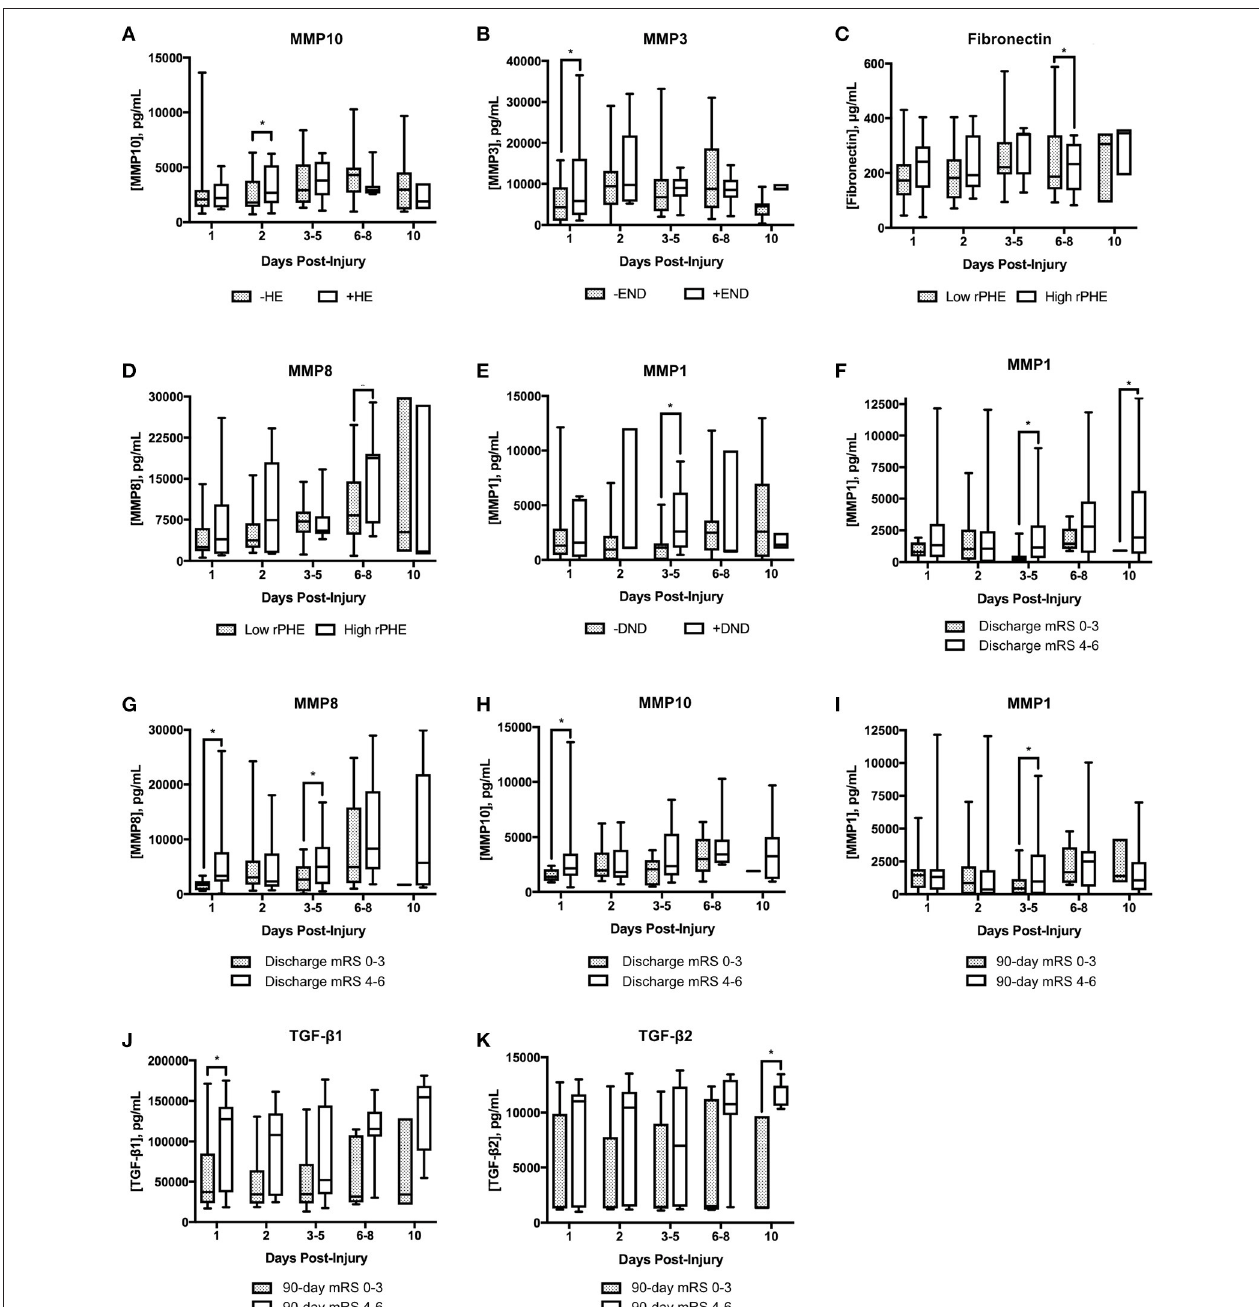
FIGURE 1 | Box plots of serum cytokine levels across timepoints as separated by ICH outcomes. (A) MMP10 levels in patients without or with hematoma expansion (HE); (B) MMP3 in patients without or with early neurologic deterioration (END); (C) fibronectin in patients with low or high relative perihematomal edema (rPHE); (D) MMP8 levels in patients with low or high rPHE; (E) MMP1 in patients without or with delayed neurologic deterioration (DND); (F–H) cytokine levels in patients with favorable (0–3) vs. unfavorable (4–6) modified Rankin Scale (mRS) score at discharge; (I–K) cytokine levels in patients with favorable versus unfavorable mRS at 90 days. * p ≤ 0.05. MMP, matrix metalloproteinase; TGF, transforming growth factor.